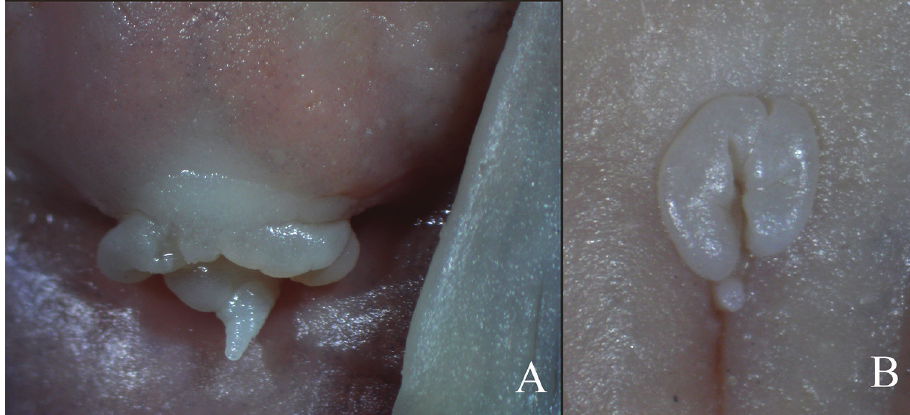
Figure 4. Ventral view of anus and external genital papilla of Oreoglanis hponkanensis . A SEABRI CXY20150106, paratype, male, 120.64 mm SL B SEABRI CXY20150078, paratype, female, 88.78 mm